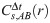
Effects of active noise on chromosome organization and dynamics.(A) MSD of active and inactive loci compared with those under passive condition. Log-log plot is shown in the panel on the right. (A) shares the same legend with (B). (B) Distribution of active (A1) and inactive (B3) loci with and without active noise. In the presence of active noise, the segregation of active and inactive loci is more evident. (C) Relaxation times estimated from the intermediate scattering functions. The wave number k was mapped to the corresponding number of loci inside the volume defined by the wave number. The red star symbols, the relaxation times in the presence of active noise, are depicted for the comparison with those under passive condition. (D) Correlation lengths for varying Δt calculated using the loci displacement correlations under passive (Fig 3A) and active (S7 Fig) conditions are compared. (E) Correlation length calculated for different types of loci from spatial correlation functions, Cs,ABΔt(r), Cs,BBΔt(r), Cs,AAΔt(r), in the presence of active noises.